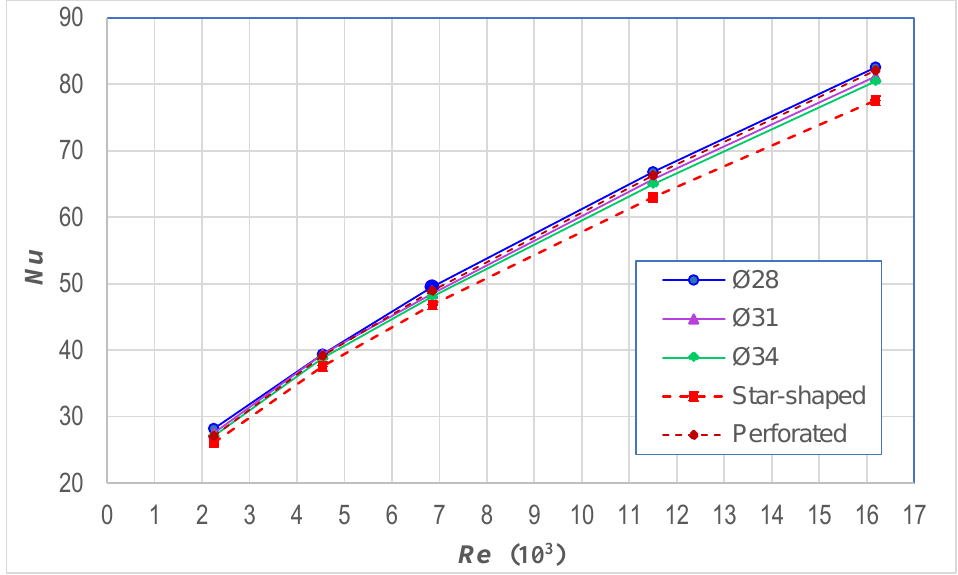
Figure 11. Nu number versus Re.